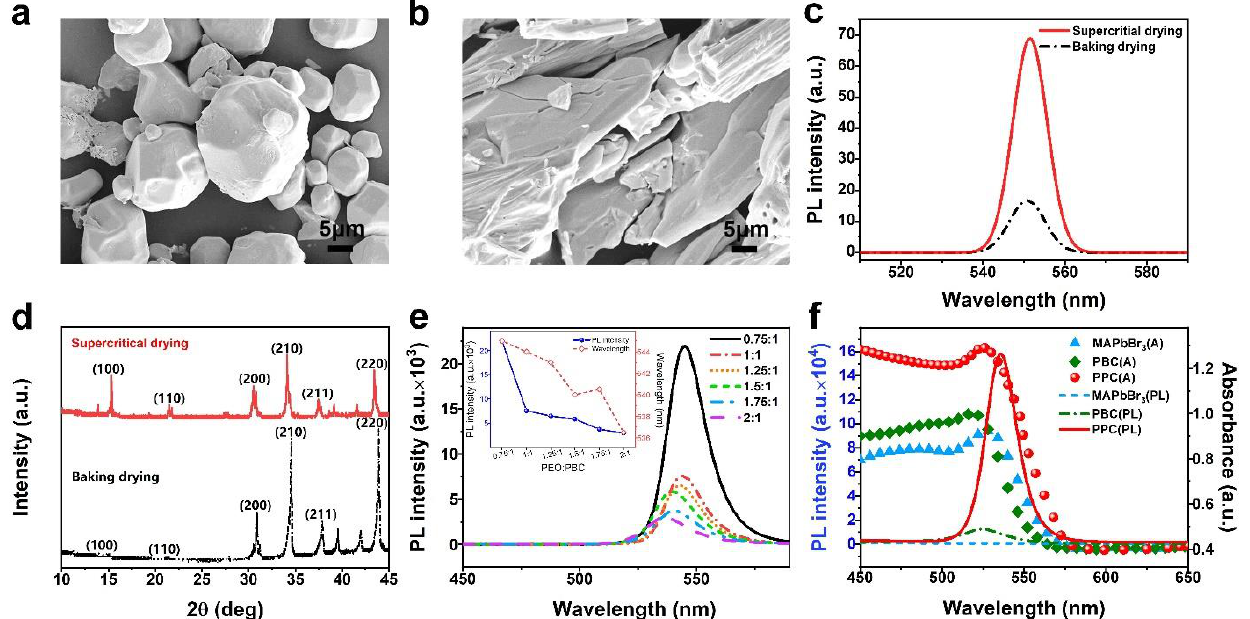
Figure 2. PL characterization of perovskite. SEM images of ( a ) supercritical drying and ( b ) baking drying at 5 μ m. ( c ) The photoluminescence image of MAPbBr 3 under both baking and supercritical drying methods, with an excitation wavelength of 365 nm. ( d ) XRD spectra related to different dry methods. ( e ) The fluorescence image of PPC films with different mass ratios of PEO/PBC in RH 10%. Inset: The image of PPC of variation of peak intensity and wavelength with PEO/PBC at different mass ratios. ( f ) The photoluminescence (the lines) spectra and absorption (the symbols) at the regions labeled MAPbBr 3 (blue line and blue triangle), PBC (green line and green rhomb), and PPC (red line and red sphere).